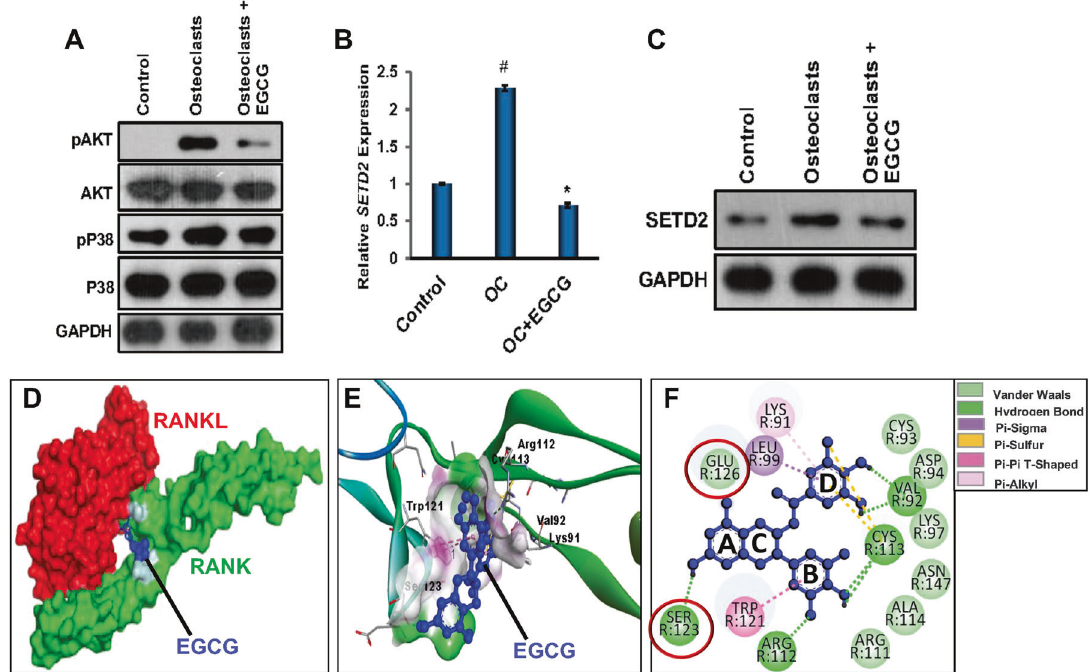
Fig. 6 Potential mechanisms, and in silico analyses for the mode of action of EGCG in the RANKL/RANK induced OC differentiation. A Western blot images are shown to evaluate the effect of EGCG in the AKT and p38MAPK signaling pathways. B qRT-PCR for determining the effect of EGCG on the expression of the SETD2 gene. C Western blot image showing SETD2 protein expression level. For qRT-PCR β -actin, and for WB, GAPDH was used as a loading control. Results are shown in mean ± SEM ( n = 3). (#), p < 0.05 compared with basal condition; and (*), p < 0.05 compared with induced OC differentiated condition. D 3D surface representation of ECGC-RANK-RANKL complex. E 3D ribbon representation of ECGC-RANK complex. F 2D representation of EGCG-RANK complex. Blue, red, and green color represent EGCG, RANKL, and RANK,